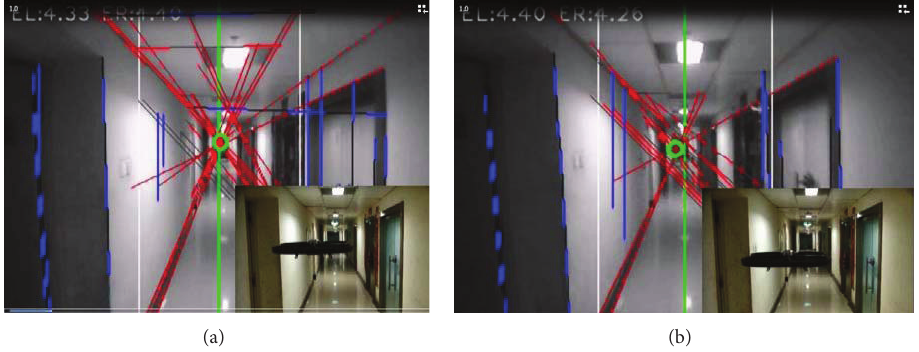
Figure 12: Flight test in the indoor